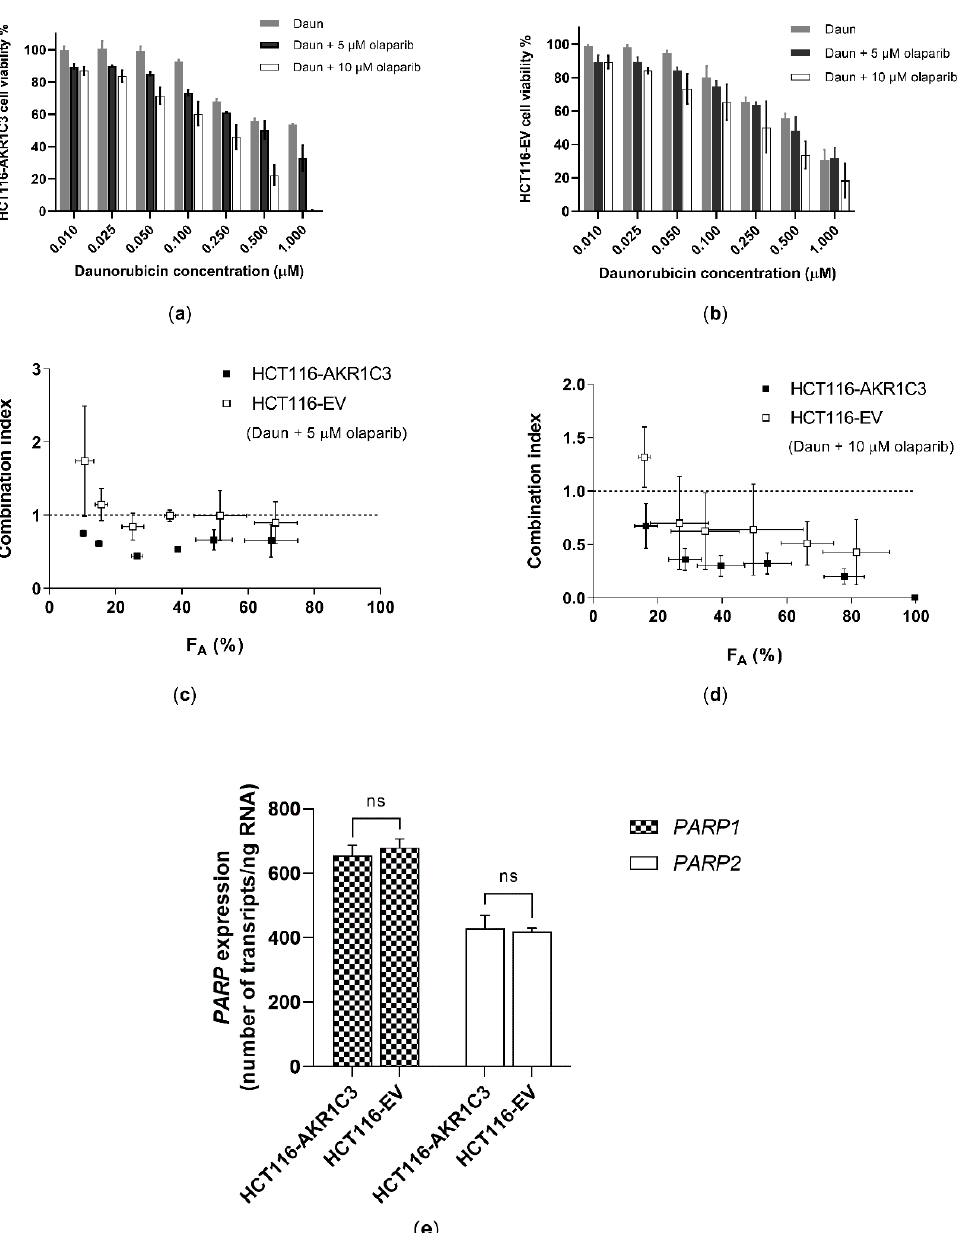
Figure 6. Effect of olaparib combined with Daun in transfected ( a ) HCT116–AKR1C3 and ( b ) HCT116–EV (empty vector) subline. GraphPad Prism 8.4.0 was used to perform the normalization of absorbance values; 0% and 100% were assigned to cells incubated with 10% DMSO and vehicle control, respectively. Data are expressed as the mean ± SD from three independent assays. Daun alone, olaparib alone, and their combinations were further analysed by the Chou–Talalay method, generating combination indices (CoI). CoI < 0.9 represents synergism, CoI > 0.9 and <1.1 represents additivity, and CoI > 1.1 represents antagonism. Cells affected (F A )–CoI plot of ( c ) 5 µM olaparib with Daun and ( d ) 10 µM olaparib with Daun. ( e ) PARP1 and PARP2 expression was quantified using quantitative reverse transcription real-time PCR (qRT-PCR) in transfected HCT116 cells. The expression data were statistically analysed using a two-tailed unpaired t -test. Data are presented as the mean ± SD from three independent transfections.